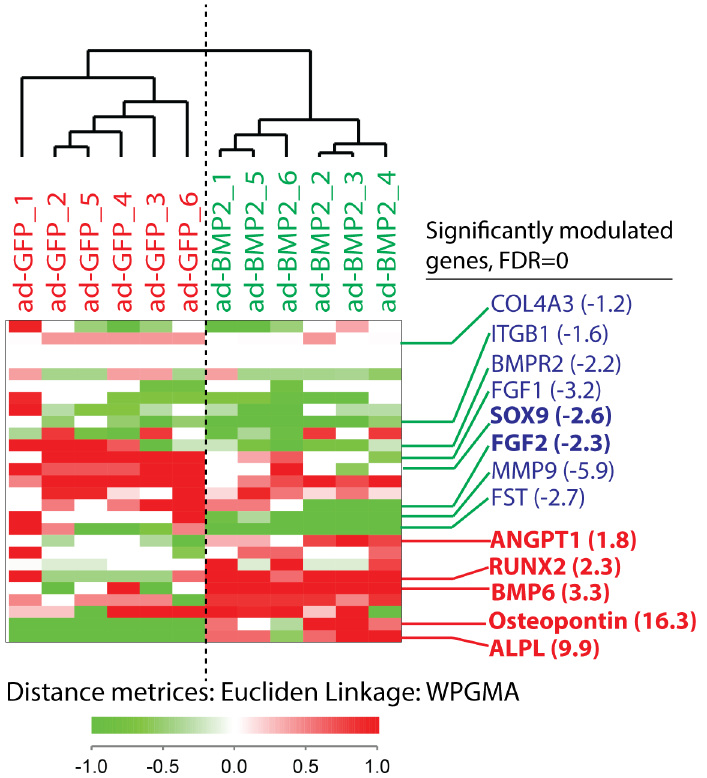
Fig 4. BMP2 over-expression mediated bone formation is associated with up-regulation of osteogenic markers in the in vivo scaffold explants. Custom PCR array was used to examine differentially expressed osteogenesis and angiogenesis related genes in scaffold explants at 2 weeks. Unsupervised hierarchal clustering demonstrated two separate clusters of the biological replicates ( n = 6) from ad-BMP2 and ad-GFP BMSC groups. SAM analysis revealed significant up-regulation (FDR = 0) of a number of osteogenesis related genes such as SPP1 (osteopontin) , ALPL , RUNX2 , BMP6 , ANGPT1 in ad-BMP2 explants as compared to the ad-GFP explants.